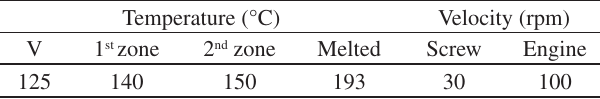
Table 1. Extrusion conditions for the PHB/PP blends.